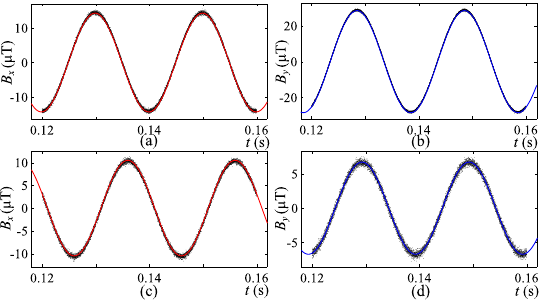
Fig. 16 The fitted sine wave of dual-axis magnetic field. a x -axis upstream of the fault point; b y -axis upstream of the fault point; c x -axis downstream of the fault point; and d y -axis downstream of the fault